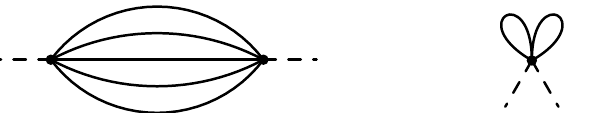
Figure 4. The two minimal two-point function Feynman diagrams used in the iterative construc- tion of melon-tadpole diagrams. The melon is based on wheel vertices and the double tadpole is based on any of the interactions I i